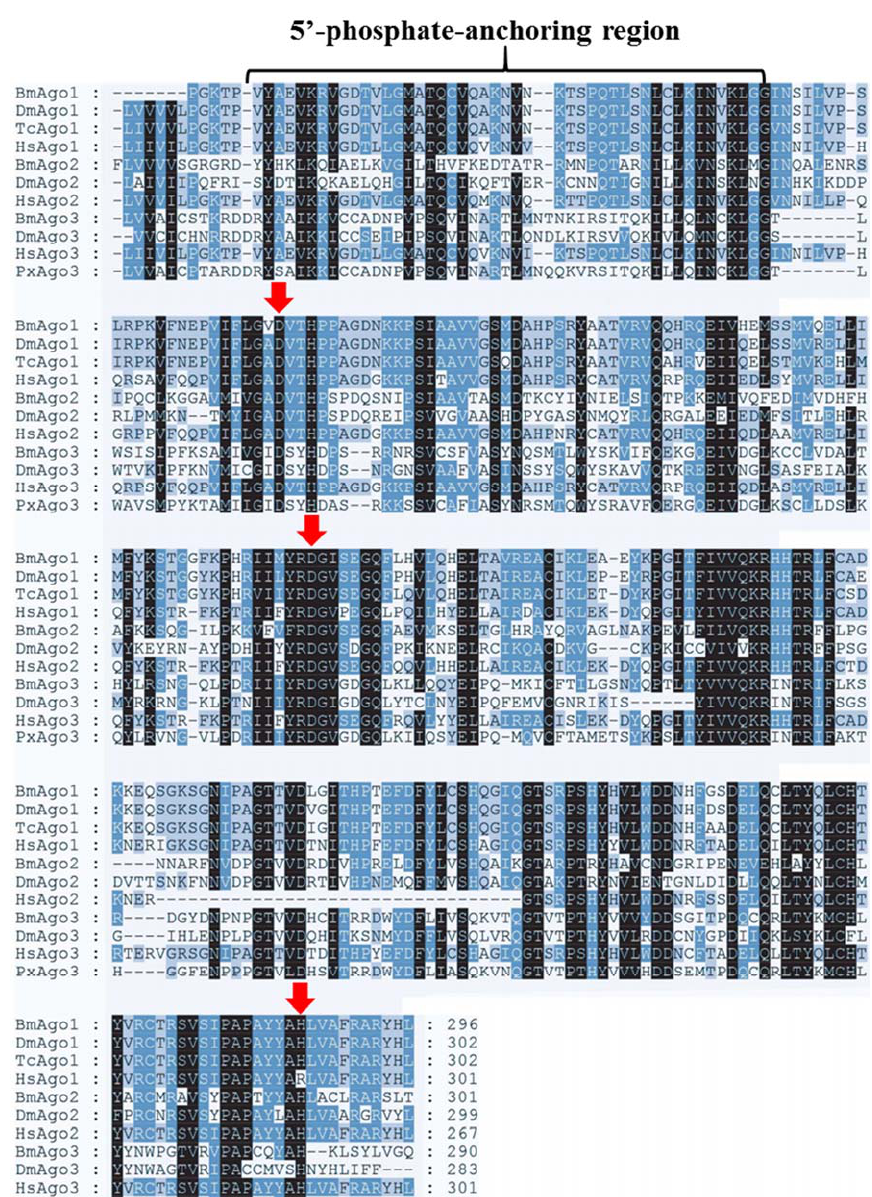
Figure 2. Multiple ‐ sequence alignment of the PIWI domain of PxAgo3 with those of other species. Multiple ‐ sequence alignment of the PIWI domains of PxAgo3 and descriptive Ago proteins by using the ClustalW software (Omega, Bienne, Switzerland). The undistinguishable amino acids are marked in black shadow, whereas alike amino acids are denoted in blue and grey shadow. The location of catalytic residues of DDH motif are specified with red arrows. Bm means Bombyx mori ; Dm, Drosophila melanogaster ; Tc, Tribolium castaneum ; Hs, Homo sapiens ; Px, Plutella xylostella .